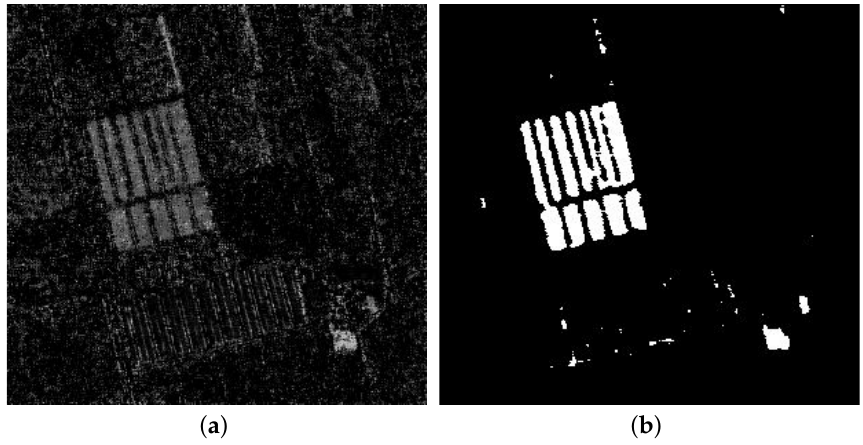
Figure 10. ( a ) Difference map of the farmland dataset. ( b ) Resulting map by the deep capsule